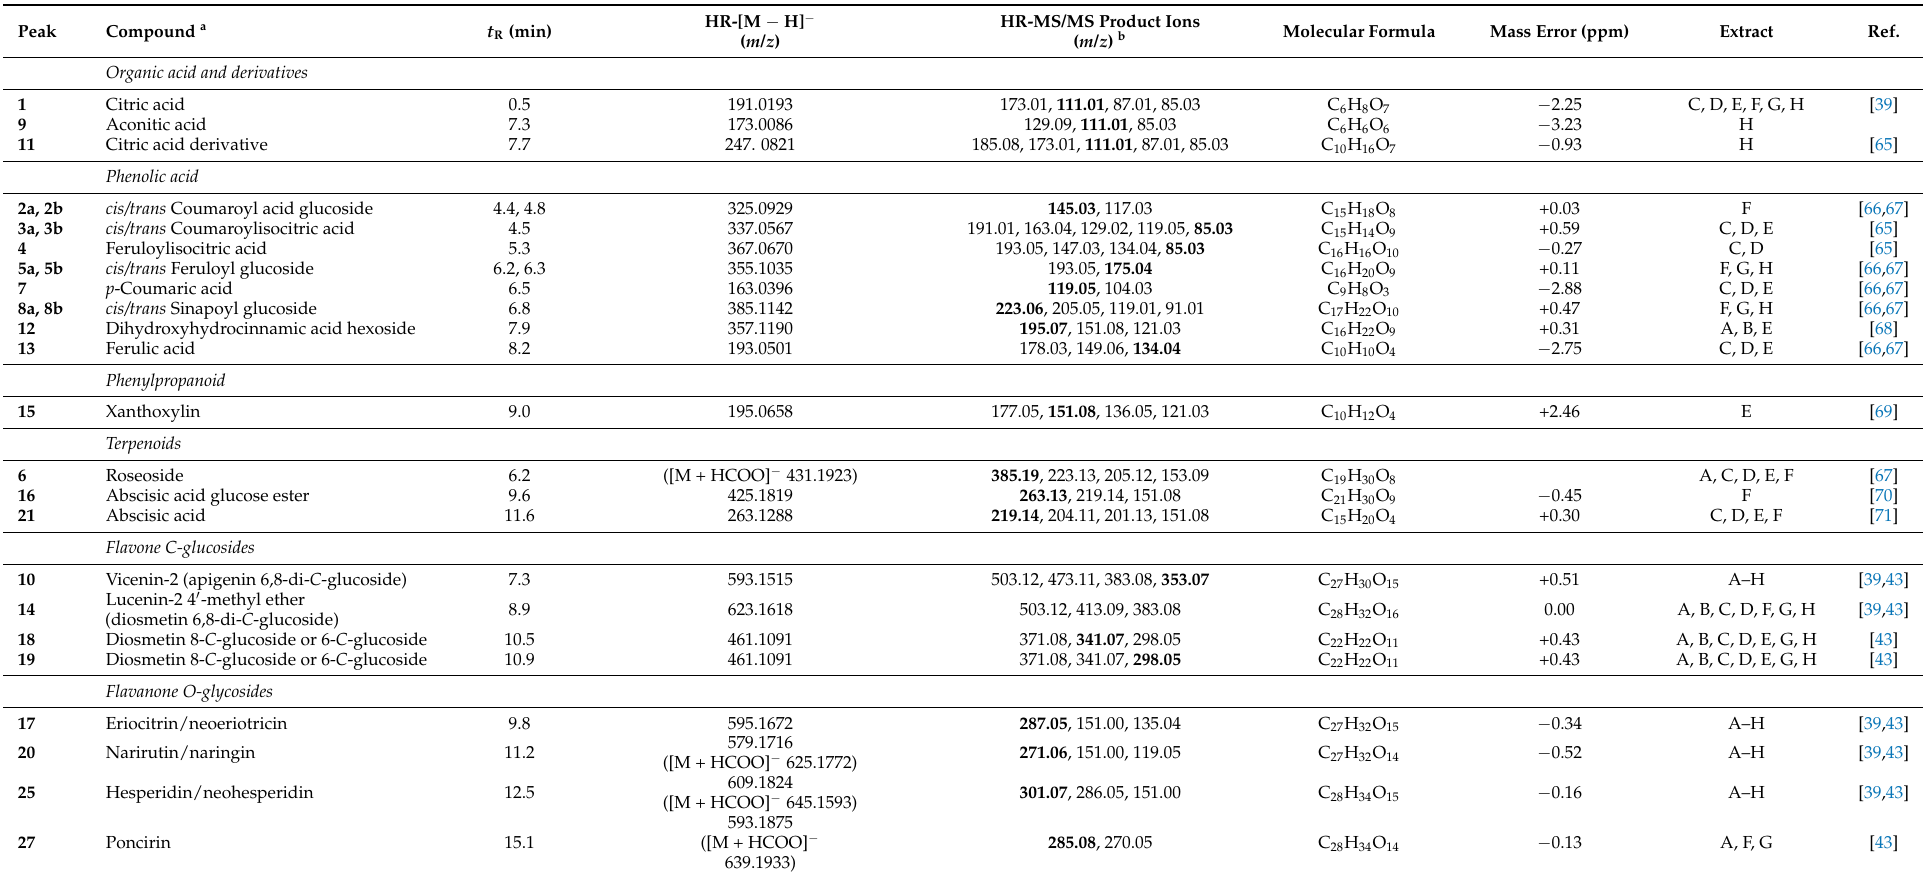
Table 4. Chromatographic and mass spectrometry data of compounds identified in the analysed samples: Coctura Mixed Citrus (A), Coctura Lemon (B),